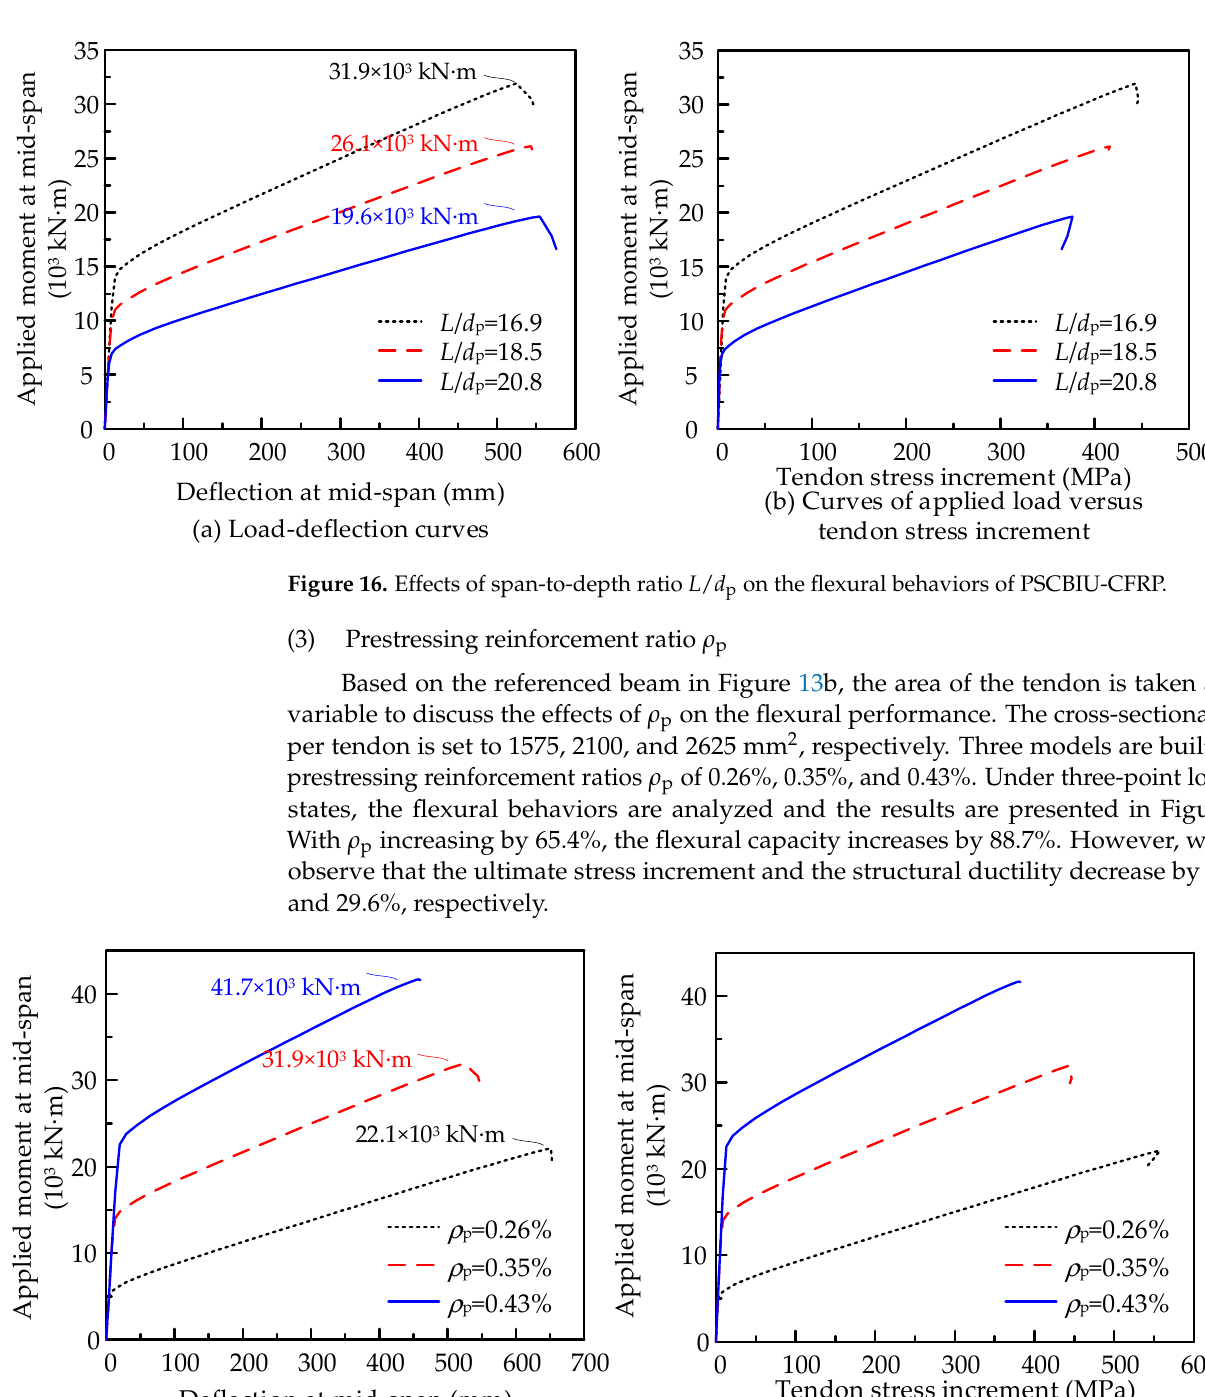
Figure 17. Effects of ρ p on the flexural behaviors of PSCBIU-CFRP.